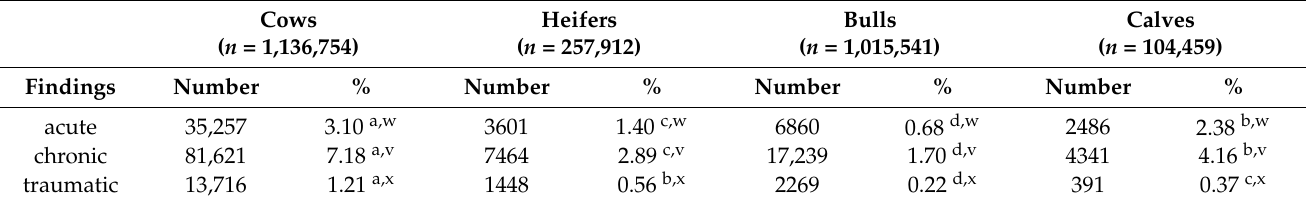
Table 5. Comparison of the occurrence of pathological findings in the limbs in cows, heifers, bulls and calves slaughtered in slaughterhouses.